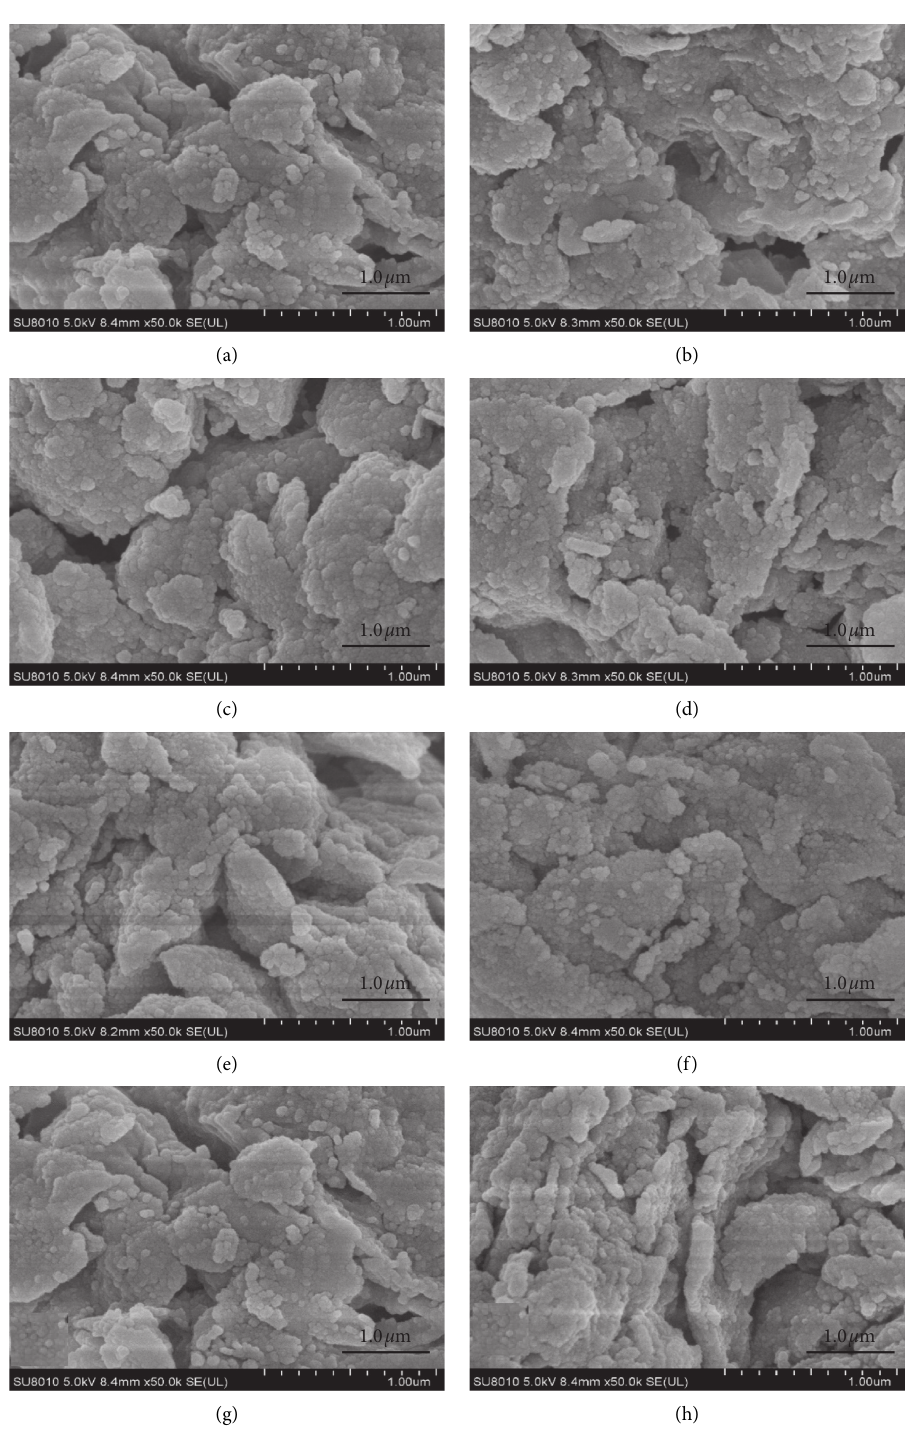
Figure 1: SEM images of K10-Mont (a, b), 1.5 OH/Fe-Mont (c, d), 0.5 Fe/Al-Mont (e, f), and OH/Fe-Mont (g, h) before and after adsorption of